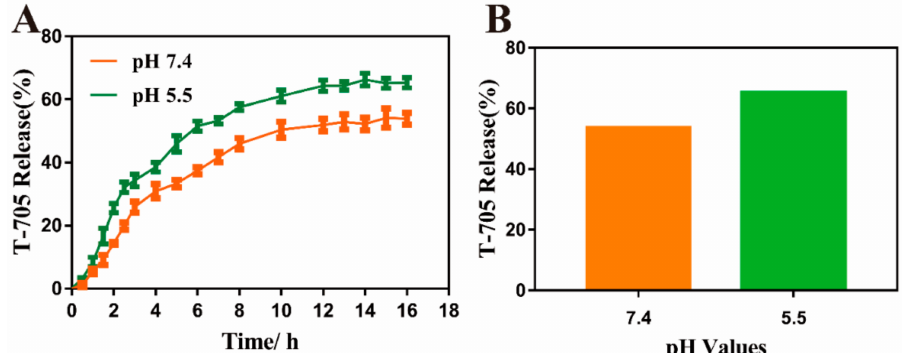
Figure 7. ( A ) The release curve of MIL-101(Fe)-T705 under different pH values. ( B ) The total release of